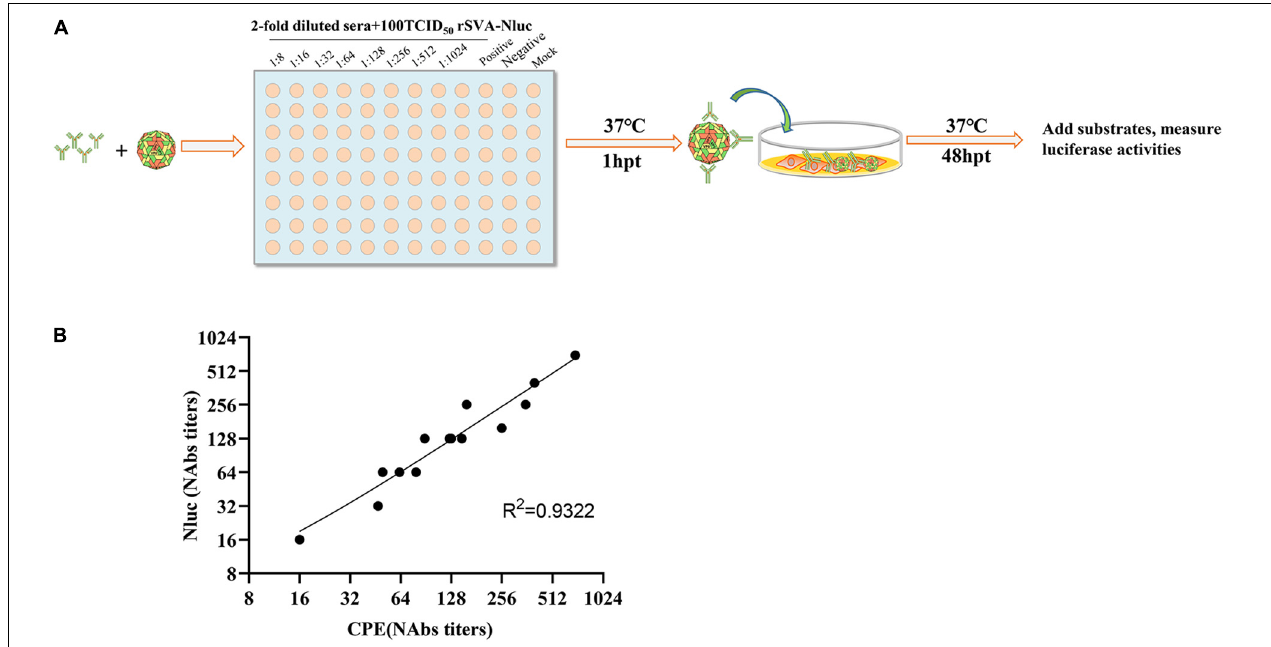
FIGURE 4 | Correlation between SVA-Nluc and traditional PRNT50 assays. (A) A schematic of the rapid neutralization assay. (B) The relationship between the traditional PRNT50 assays and the logarithms of the Nabs titers was analyzed based on the data from 13 serum samples.